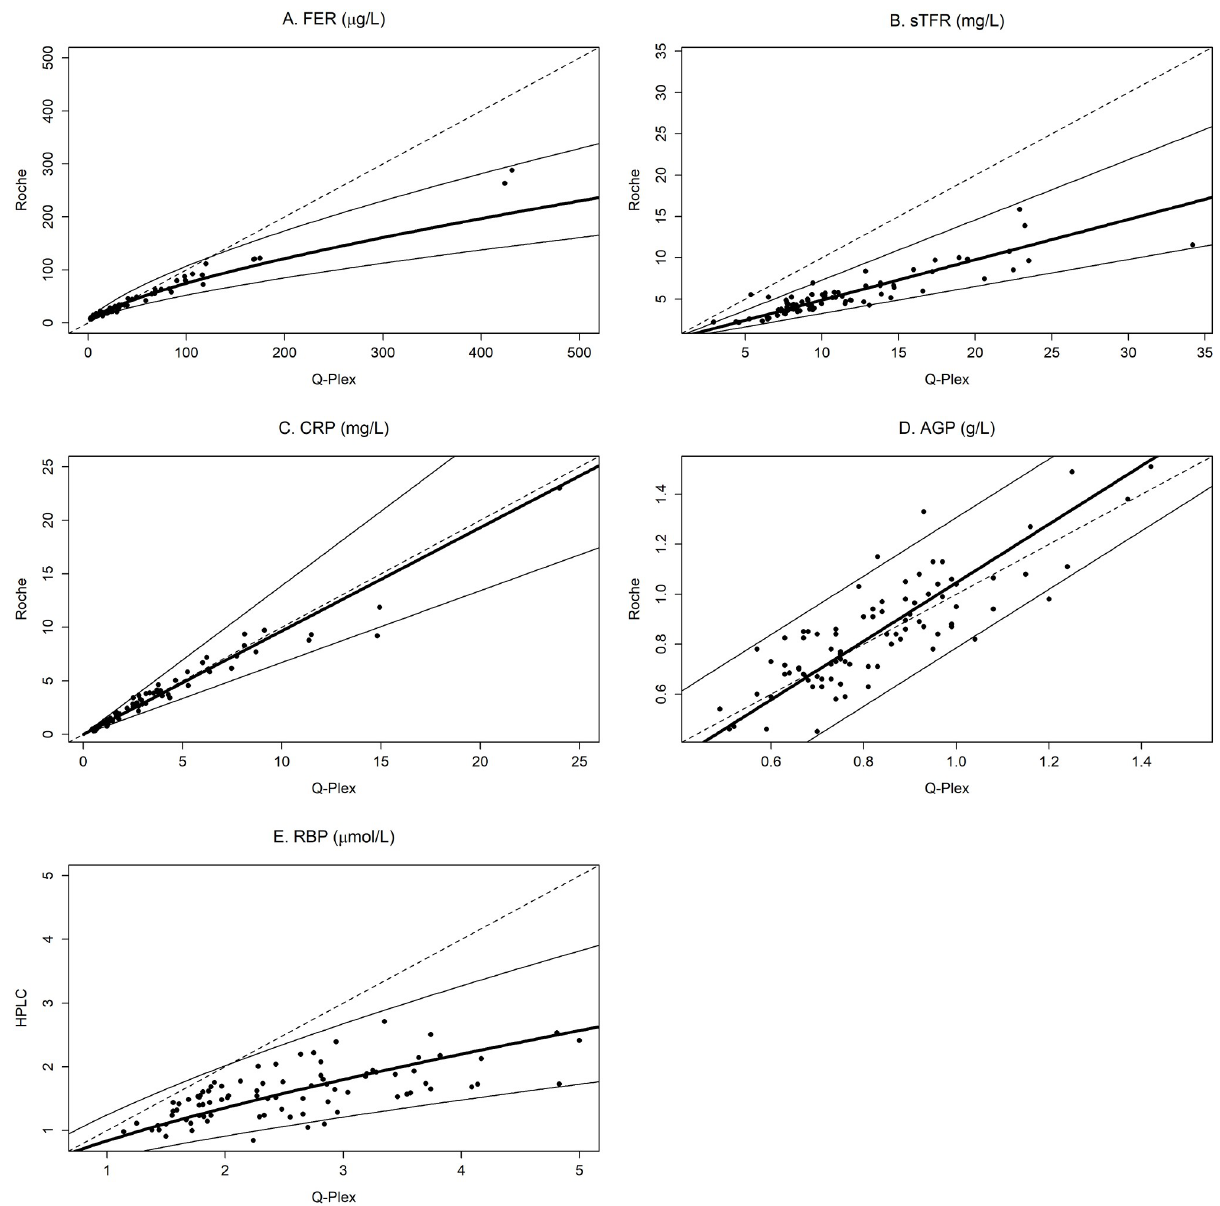
Fig 1. Prediction plots of the test assay on the y-axis and the reference assay on the x-axis showing the prediction line and 95% prediction intervals. The prediction lines and 95% limits are applicable both ways. The dashed line represents the line of identity.